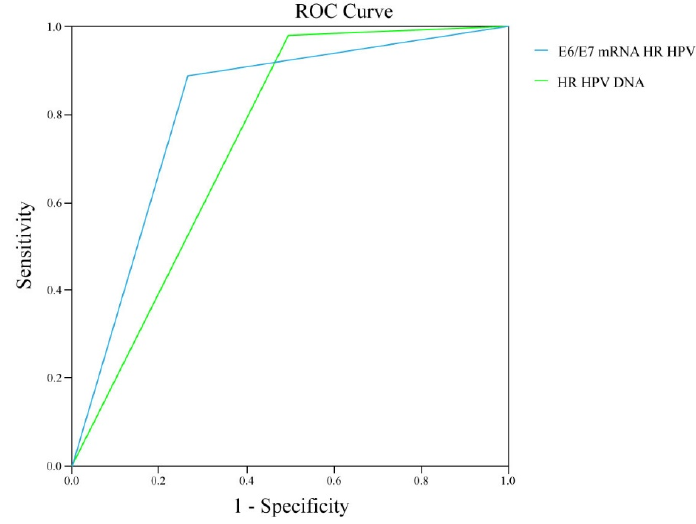
Figure 5. ROC curve of HR HPV and E6/E7 HR HPV tests in HSIL. The relationships between the oncogenic activity of all of the tested HPVs and previ ‐ ously singled out HPV 16 vs. the cytological results were analyzed using Spearman’s ( ρ ) correlation (Figure 6). There is a statistically significant positive moderate correlation be ‐ tween the presence of HPV 16 oncogenic activity and cytological status (Spearman’s cor ‐ relation; ρ = 0.494; p < 0.001) (Figure 6A). The oncogenic activity of the tested HPV geno ‐ types is associated with a strong statistically significant positive correlation with the de ‐ gree of cervical intraepithelial lesion severity (Spearman’s correlation; ρ = 0.594; p < 0.001) (Figure 6B).